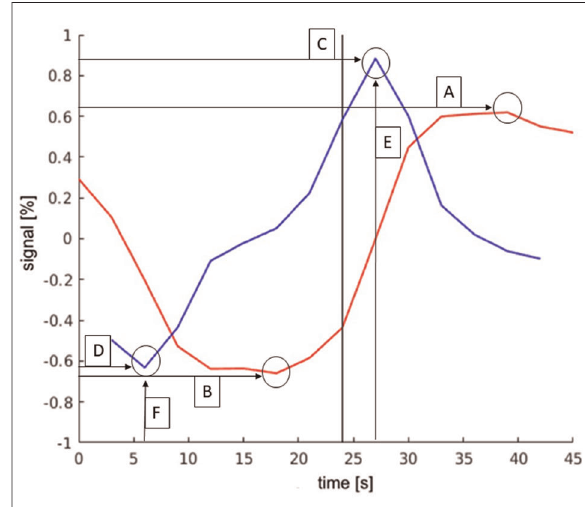
FIGURE 3 Exemplary TC and its derivation of language activations to demonstrate the parameters. The y -axis describes the deviation in the percent of the signal from the mean value of the signal. The black bar indicates the start of the activation block (at 24 s). The parameters were as follows: ( A ): maximum signal strength; ( B ): minimum signal strength; ( C ): maximum slope; ( D ): minimum slope; ( E ): time of activation onset; ( F ): time of activation